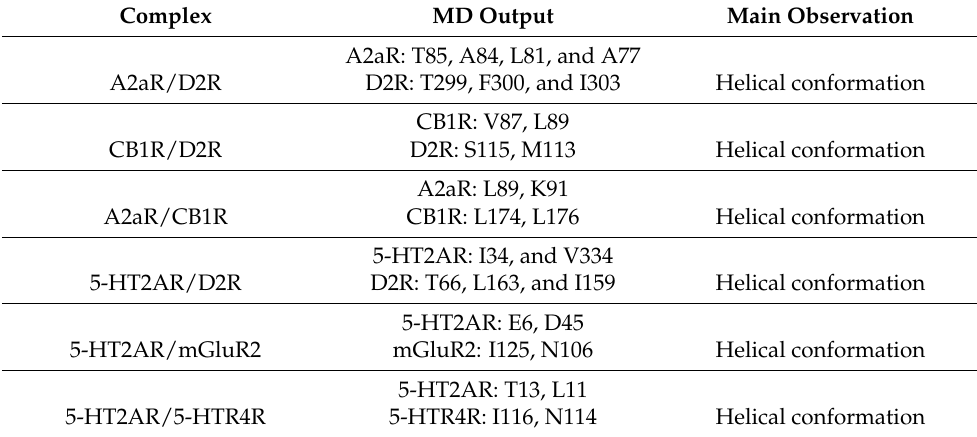
Table 2. Molecular dynamic simulations outputs. For each heterodimer, we provide the closest amino acids after interacting peptides have reached thermal equilibrium. We also provided the final conformation at the interfaces which are all